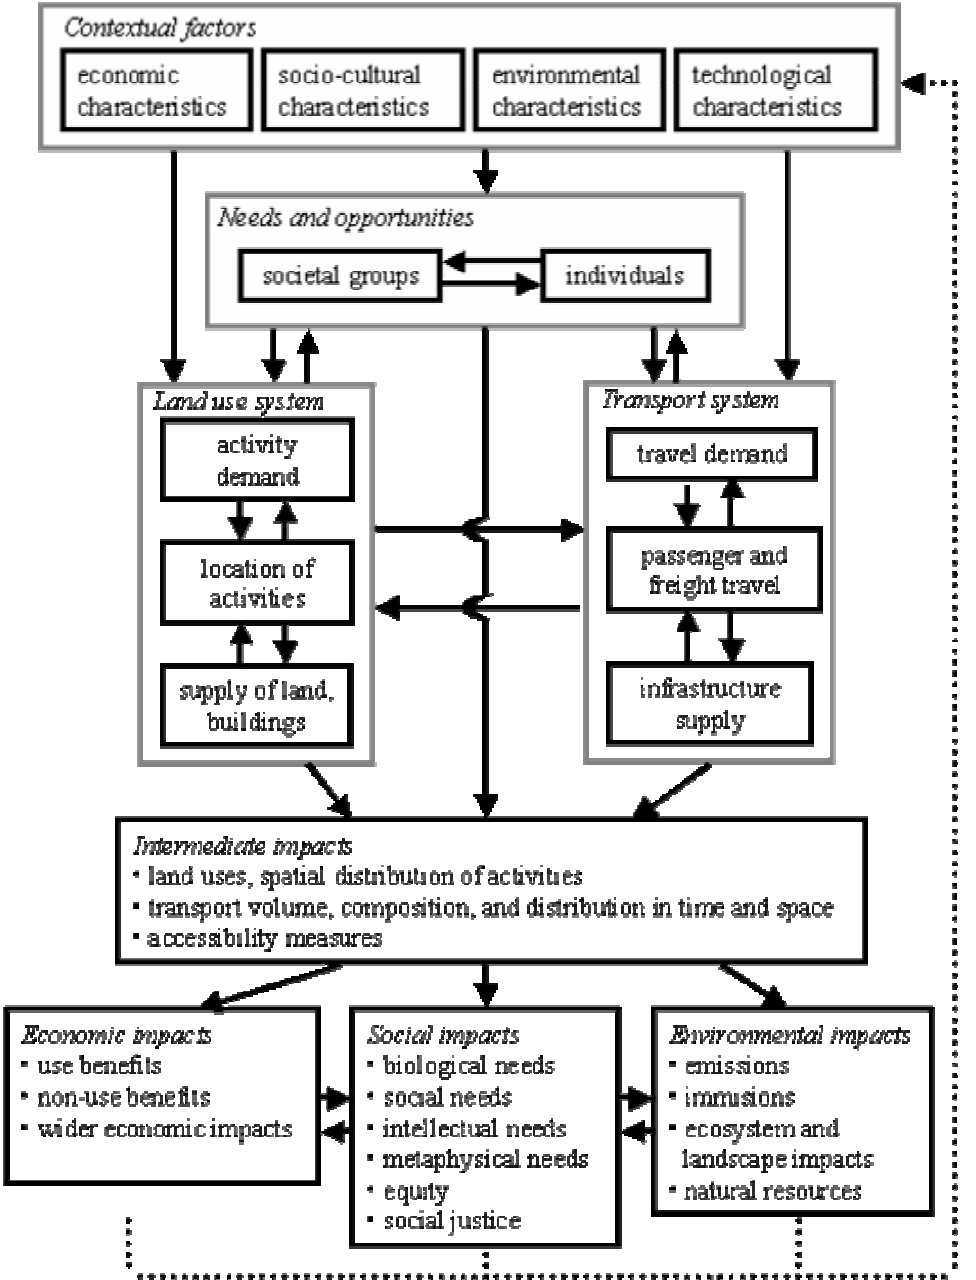
Figure 1. Conceptual model for the function and impacts of the land-use/transport